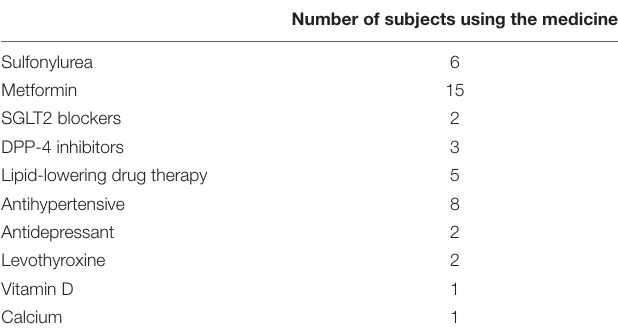
TABLE 1 | Medicine used by subjects. Number of subjects using the